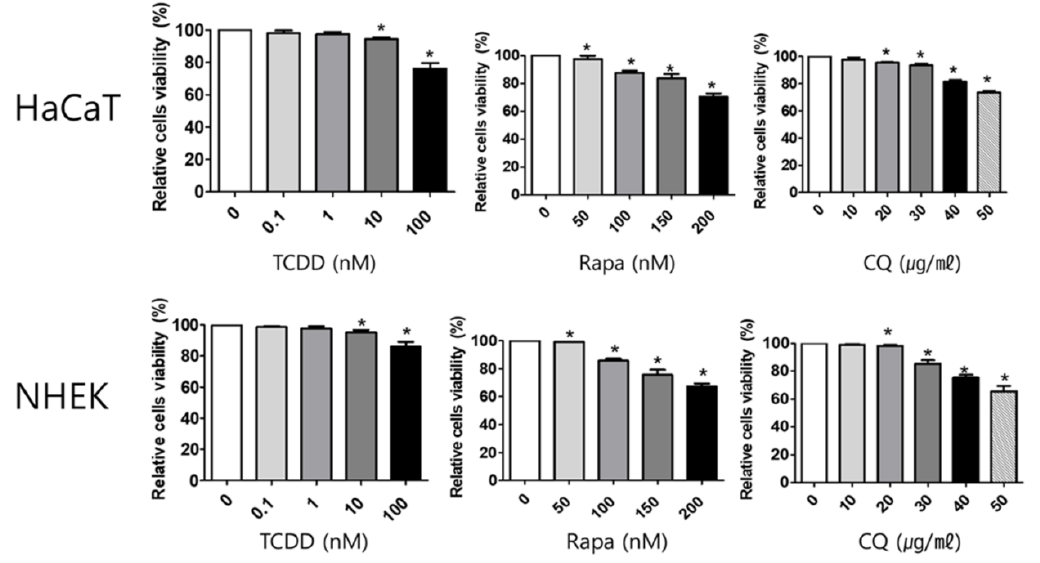
Figure 1. The e ff ect of 2,3,7,8-Tetrachlorodibenzo-p-dioxin (TCDD), rapamycin, and chloroquine on HaCaT cells and NHEK viability. After treatment of HaCaT with (a) TCDD (0, 0.1, 1, 10, and 100 nM), (b) rapamycin (0, 50, 100, 150, and 200 nM), and (c) chloroquine (0, 10, 20, 30, 40, and 50 µ g / mL) for 48 h, cell viability was measured by, 3-(4,5-dimethylthiazol-2yl)-2,5-diphenyl-tetrazolium bromide (MTT) assay. After treatment of NHEK with (d) TCDD (0, 0.1, 1, 10, and 100 nM), (e) rapamycin (0, 50, 100, 150, and 200 nM), and (f) chloroquine (0, 10, 20, 30, 40, and 50 µ g / mL) for 48 h, cell viability was measured by MTT assay. Data represent the mean ± S.D. of three independent experiments (each performed in duplicate). Statistical significance was determined by one-way ANOVA followed multiple comparison Tukey’s test. * indicates p < 0.05 in comparison to unstimulated cells. Rapa, rapamycin, CQ, chloroquine, NHEK, normal human epidermal keratinocyte.